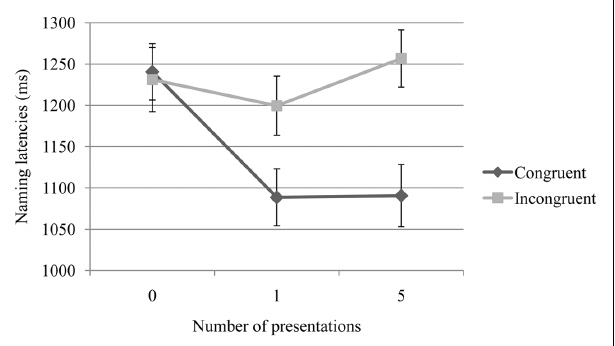
FIGURE 1 | Response latencies (in milliseconds) producing the L1 definite article for those pictures presented zero, one, or five times in the previous L2 picture naming